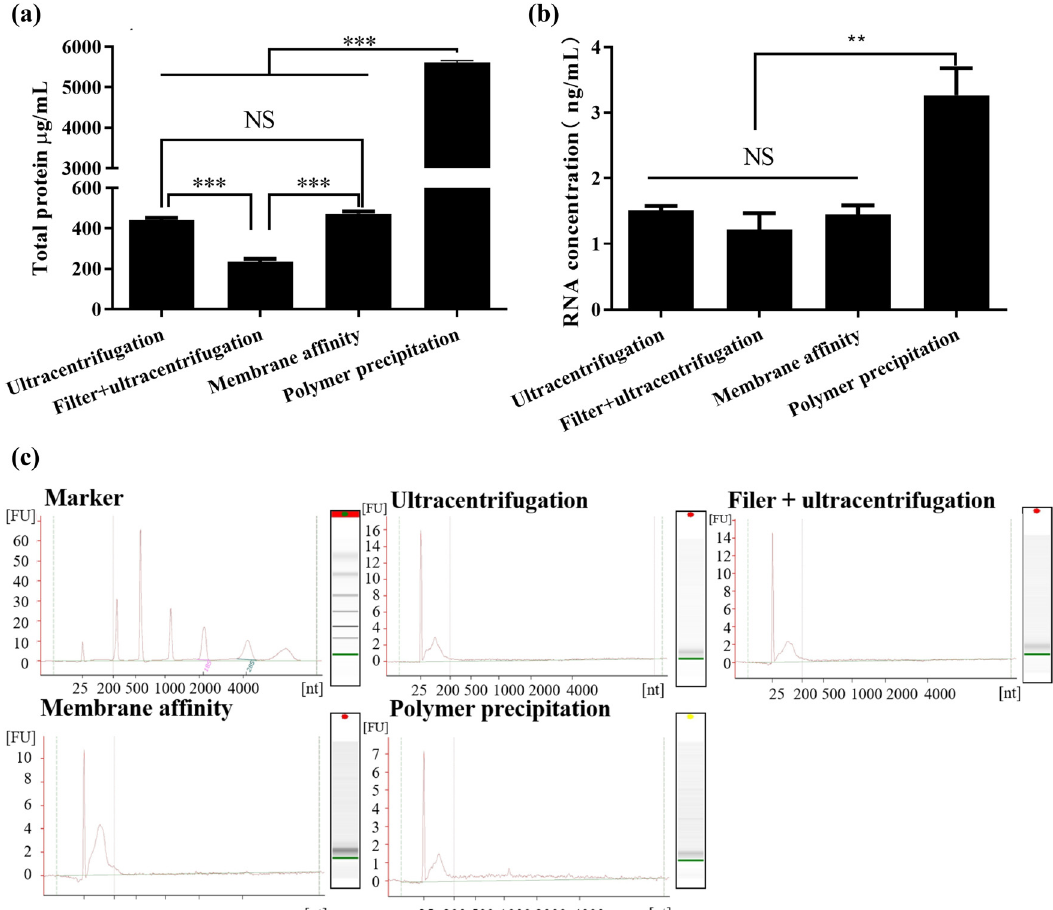
Figure 4: The yield of exosomes from di ff erent isolation procedures. ( a ) The exosomal yield presented as the protein estimation. ( b ) The exosomal yield presented as the total RNA. ( c ) Representative bioanalyzer pro fi les of RNA analyzed by an Agilent 2100 Bioanalyzer; the y - axis shows fl uorescence units ( FU ) , and the x - axis shows the nucleotide length ( nt ) of the RNA. The results are the mean ± standard error of the mean of three independent experiments. One - way analysis of variance ( ANOVA ) was used to assess the di ff erences among multiple groups, followed by Tukey ’ s post hoc test. **, P < 0.01; ***, P < 0.001. NS, P >